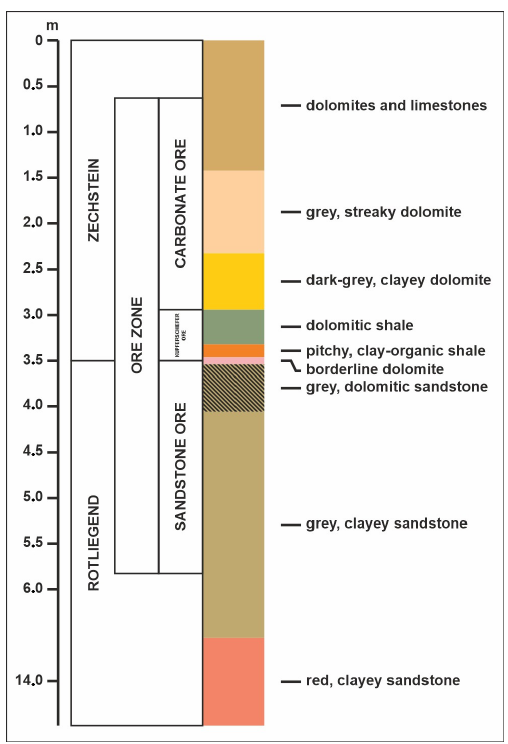
Figure 2. Geological profile of the Fore-Sudetic Monocline copper ore deposit (adapted from